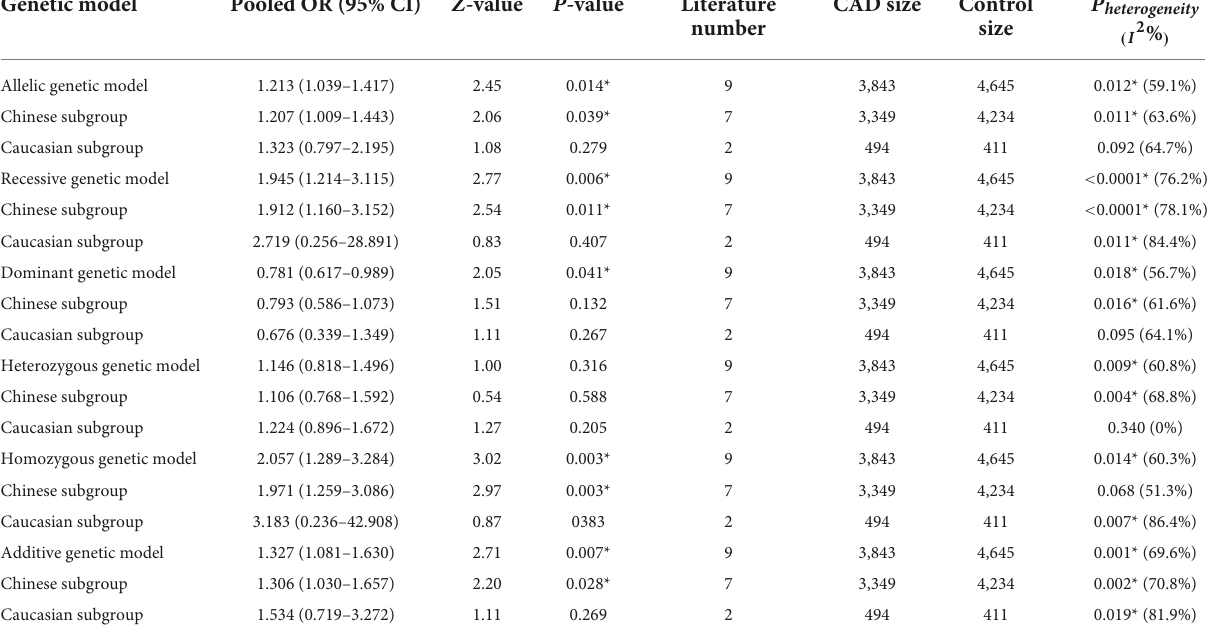
TABLE 2 Meta-analysis results of association between MIF gene rs755622 polymorphism and CAD. Genetic